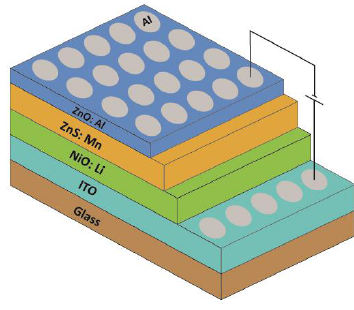
Figure 6. Schematic diagram of fabricated LED .